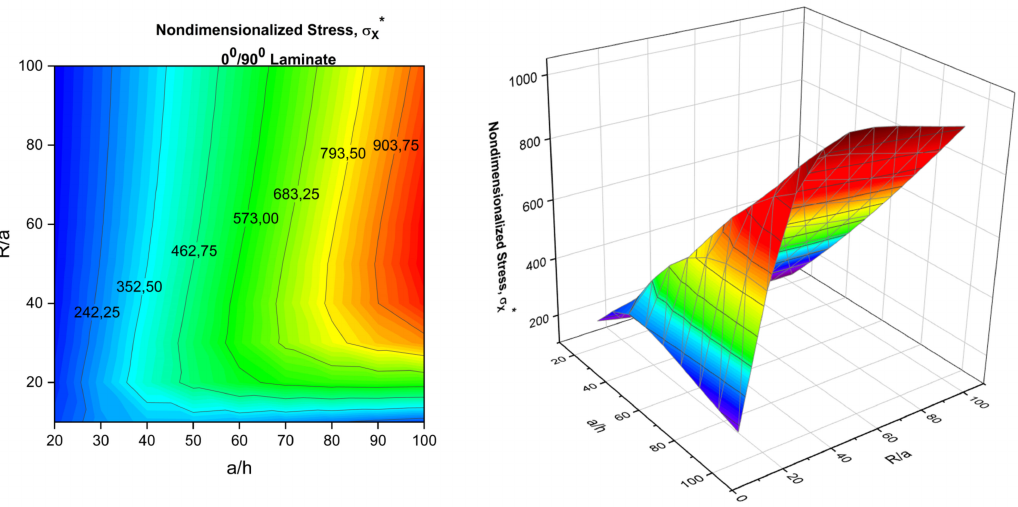
Figure 8. Nondimensional displacement, w *, of (0 ◦ /90 ◦ /0 ◦ ) spherical panels with the change of R/ a and a / h ratios.